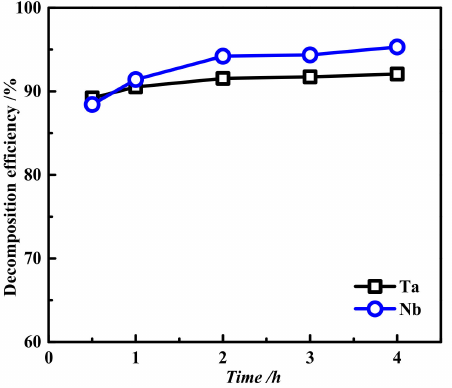
Figure 3. Effects of different decomposition times on the decomposition efficiencies of tantalum and Nb: reaction temperature 200 ◦ C, liquid–solid ratio 7:1, oxygen partial pressure 2 MPa, and basicity 40 wt.%.